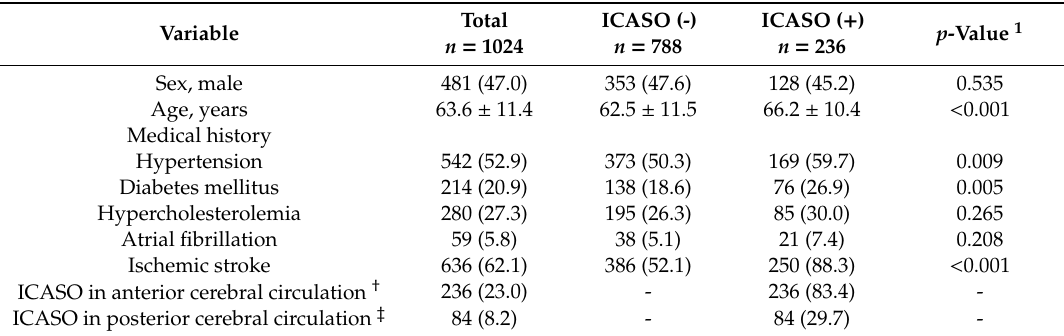
Table 1. Clinical characteristics of study